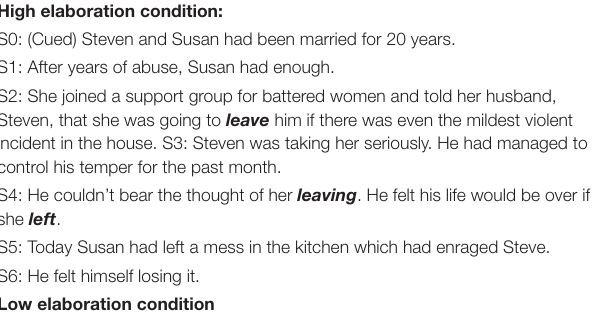
TABLE 1 | Sample text in experiments 1, 2, and